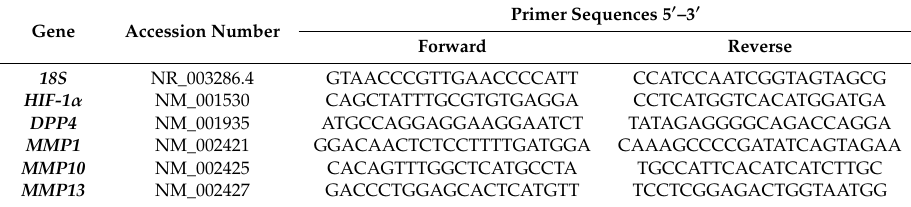
Table 1. Human primer sequences for real-time